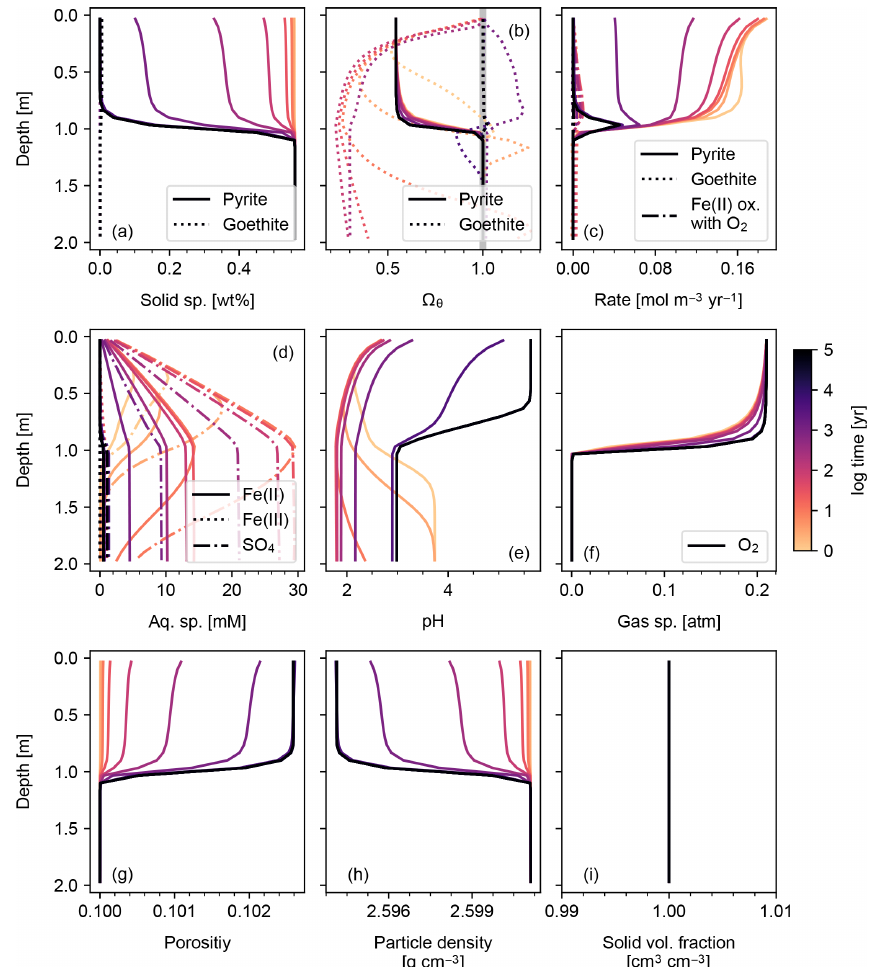
Figure 2. Simulation of abiotic weathering of pyrite. Soil concentrations and saturation states of solid species are plotted in (a) and (b) , respectively; rate profile of reactions within soil in (c) ; porewater concentrations of aqueous species and pH in (d) and (e) , respectively; concentrations of soil gases in (f) ; soil porosity and particle density in (g) and (h) , respectively; ratio of the total volume of solid species against solid space specified with porosity in (i) . See Table 7 for details on the boundary conditions of the simulation.